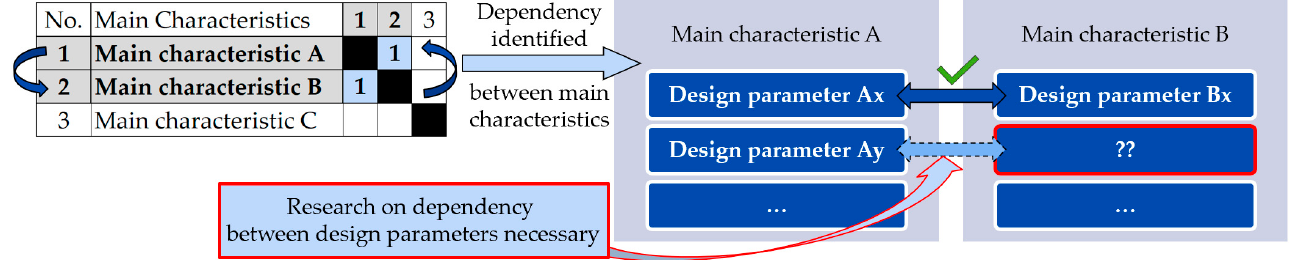
Figure 10. Extension of the identi fi ed design parameters due to consistency, adapted from [24].